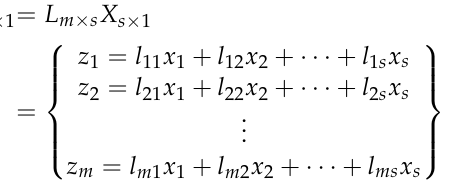
where X and Z are the original variable and the converted variable, respectively, L is the transformation matrix, s is the original variable dimension, and m is the dimension of the variable after transformation; in this paper, m =